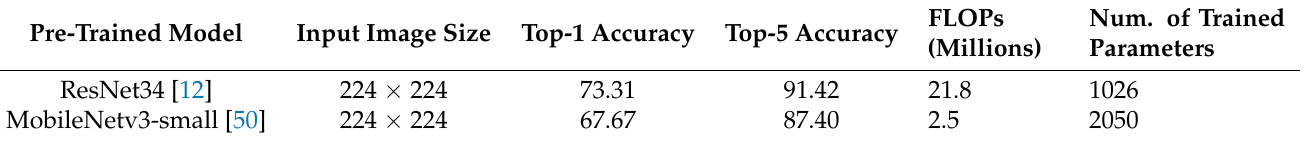
Table 2. Characteristics of the selected pre-trained